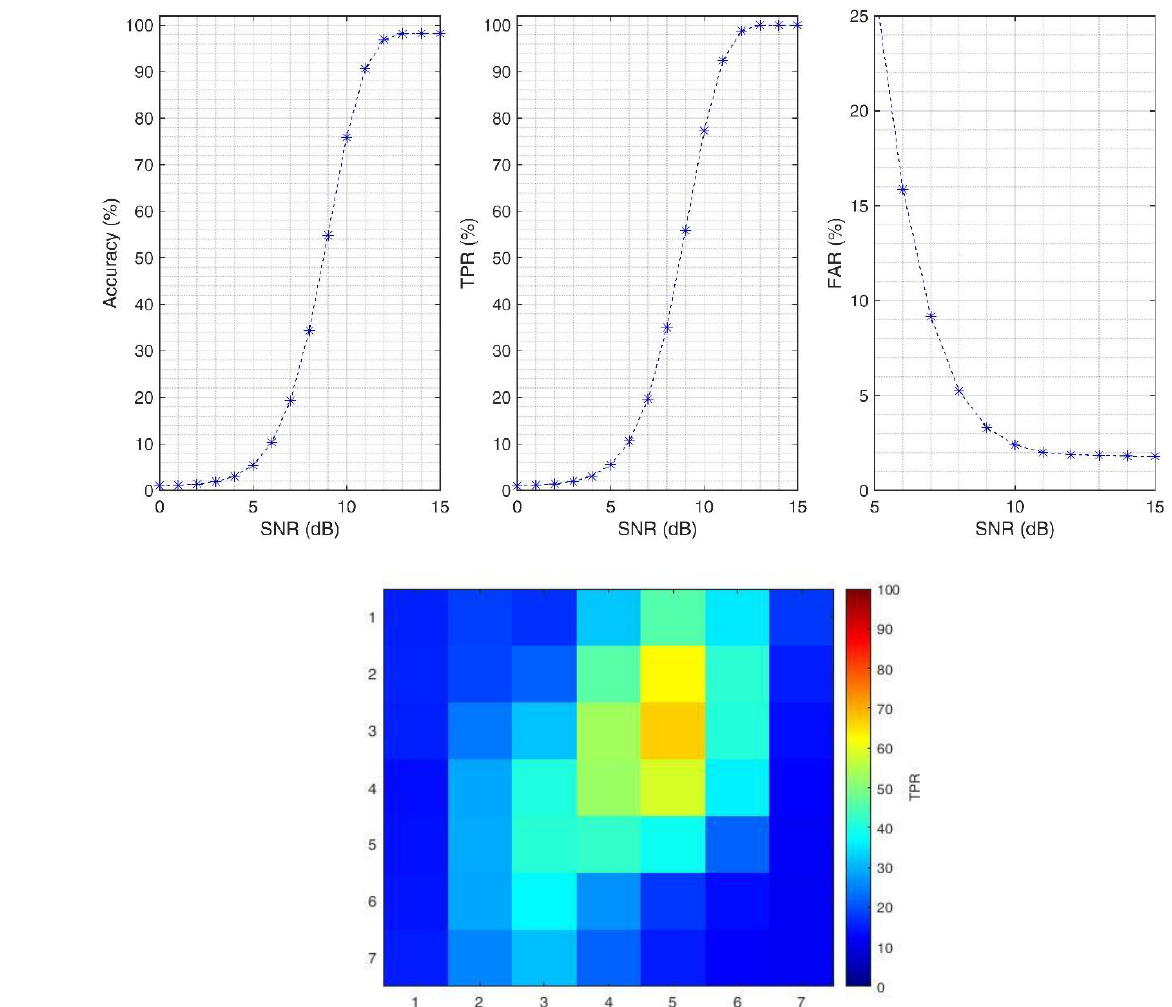
Figure 10. ( a ) Accuracy, TPR and FAR of ASO algorithm with WA and IIR as threshold and smoothing filter over different SNR levels. ( b ) the sensitivity matrix of the detector on real dataset.